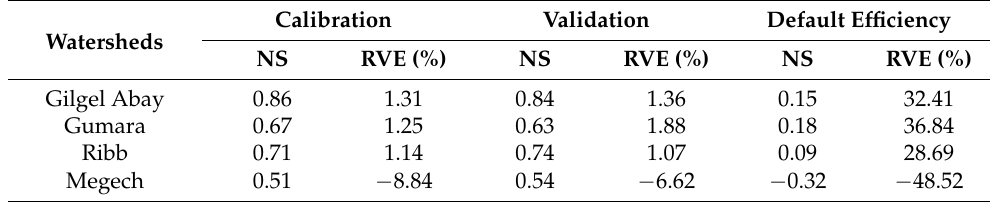
Table 3. SWAT model efficiency in simulation of stream flow of watersheds. Calibration Validation Default Efficiency Watersheds NS RVE (%)